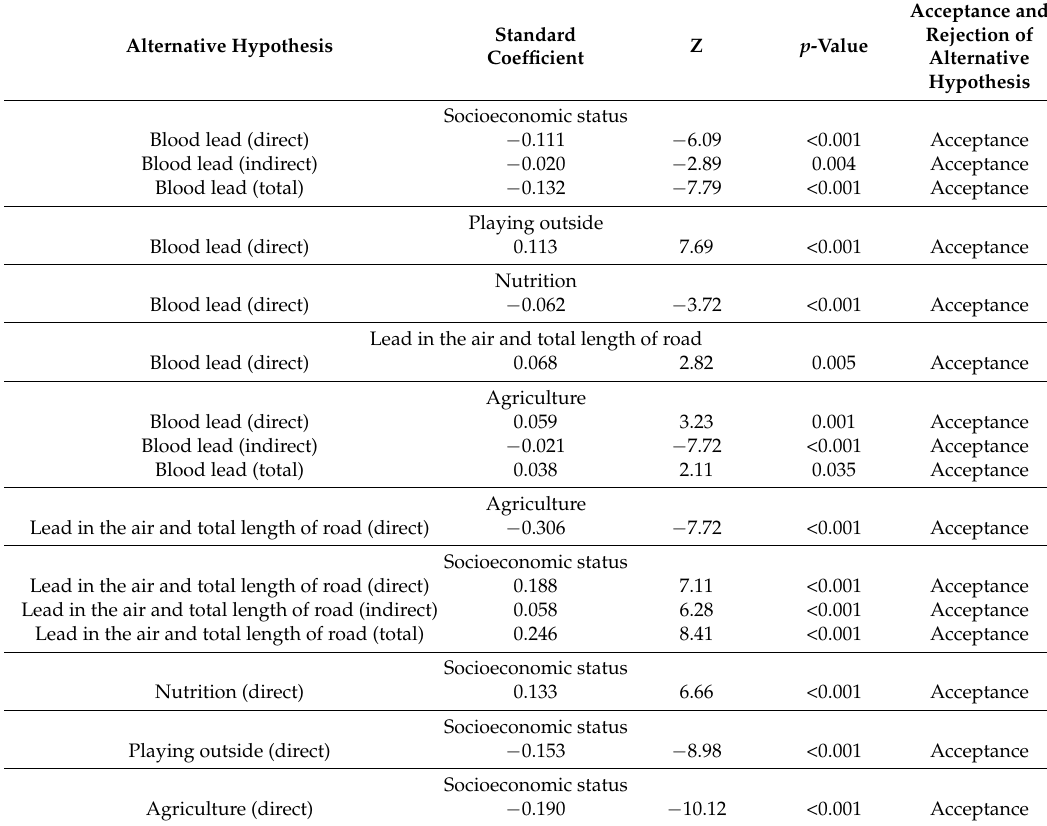
Table 3. Direct, Indirect, and Total Effects of Potential Lead Exposure Sources on Blood Lead Levels with Standardized Parameter